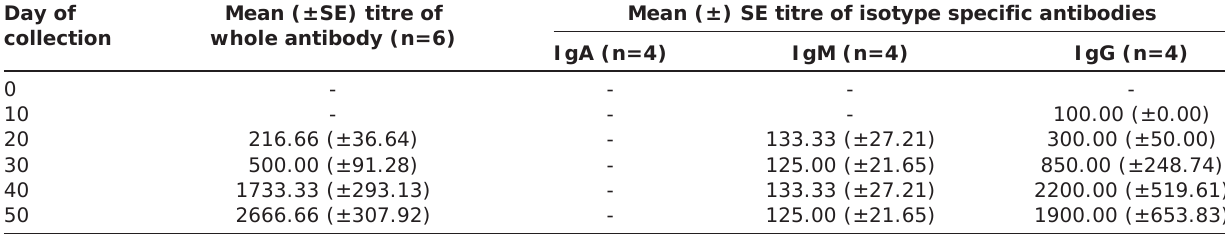
Table-1: Whole antibody titres and isotype-specific antibody titres against K88ac ETEC in serum of immunized hens as determined by indirect ELISA. Day of collection